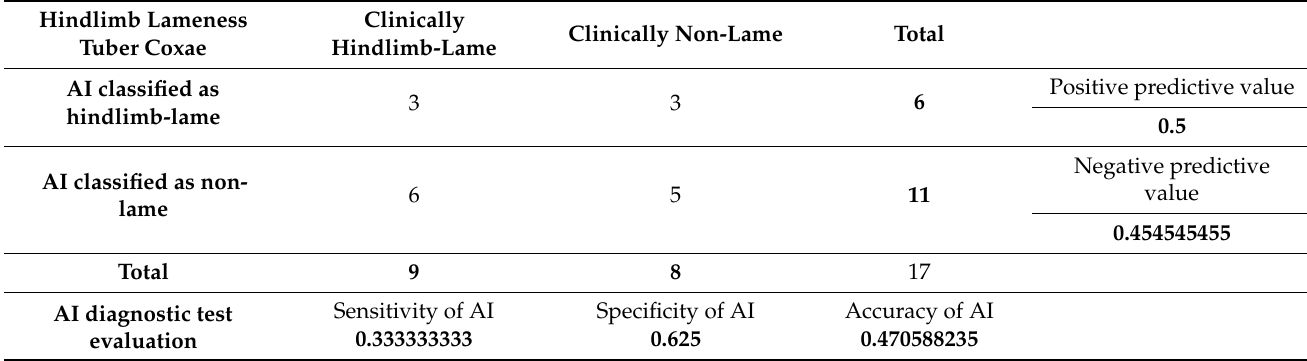
Table A6. Tuber coxae reference point—Statistical classification of horses with and without hindlimb